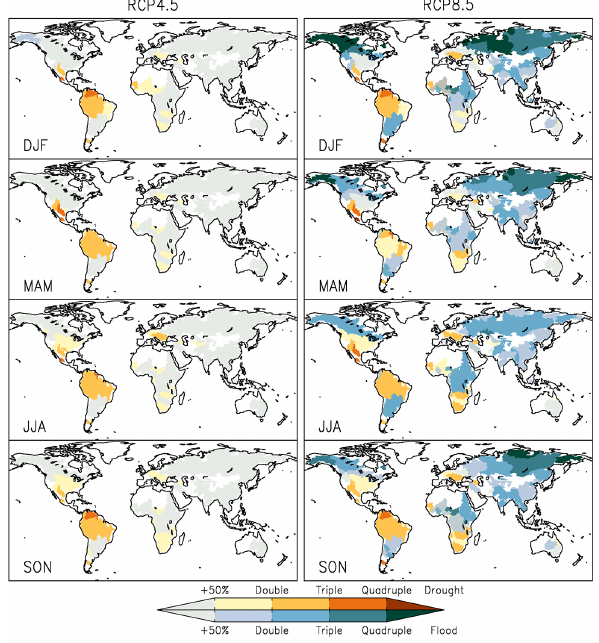
Figure 1. Multi-model estimates of change in exceedance of 10% (drought) and 90% (flood) monthly precipitation totals in the RCP4.5 case (left) and RCP8.5 case (right), based on the historical simulation climatologies, for the indicated seasons. “Double” indi- cates twice as many months exceed the historical 10% threshold for the tail of the distribution, “triple” is three times, etc.